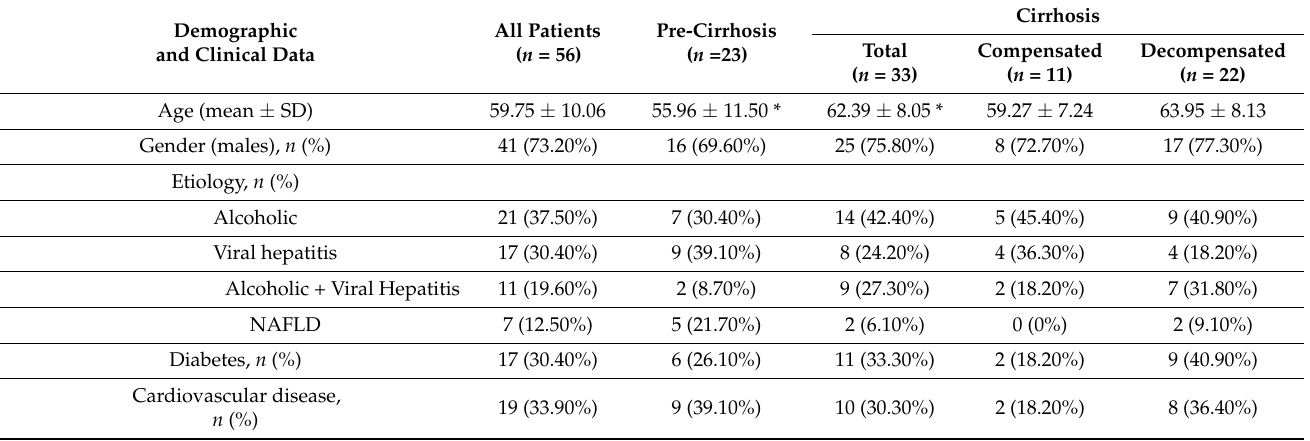
Table 1. Demographic and clinical data of patients with